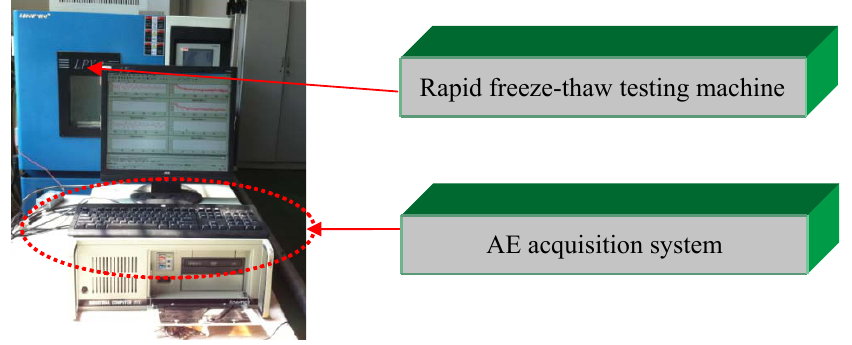
Figure 2. PVA concrete temperature fatigue damage testing experimental device.